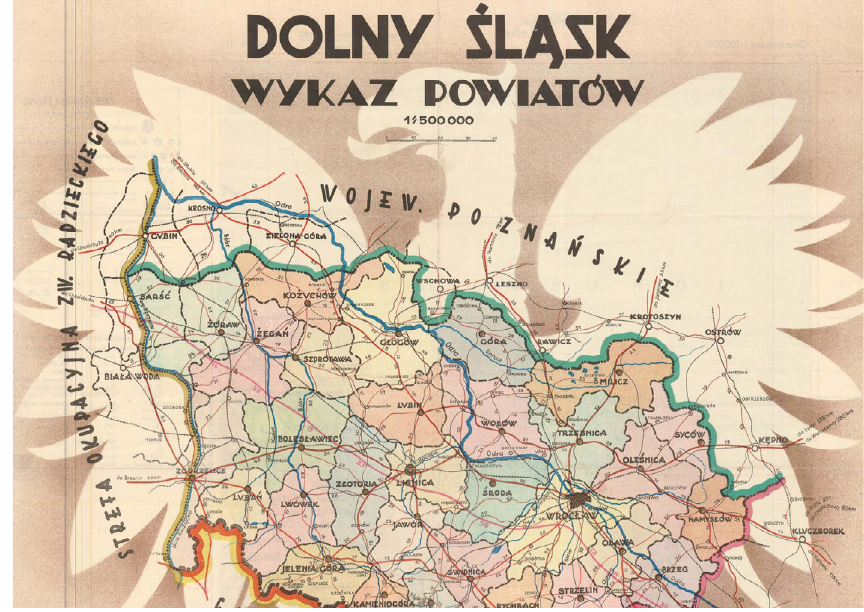
Fig. 4. Part of a map Dolny Śląsk. Wykaz powiatów , 1:500,000,